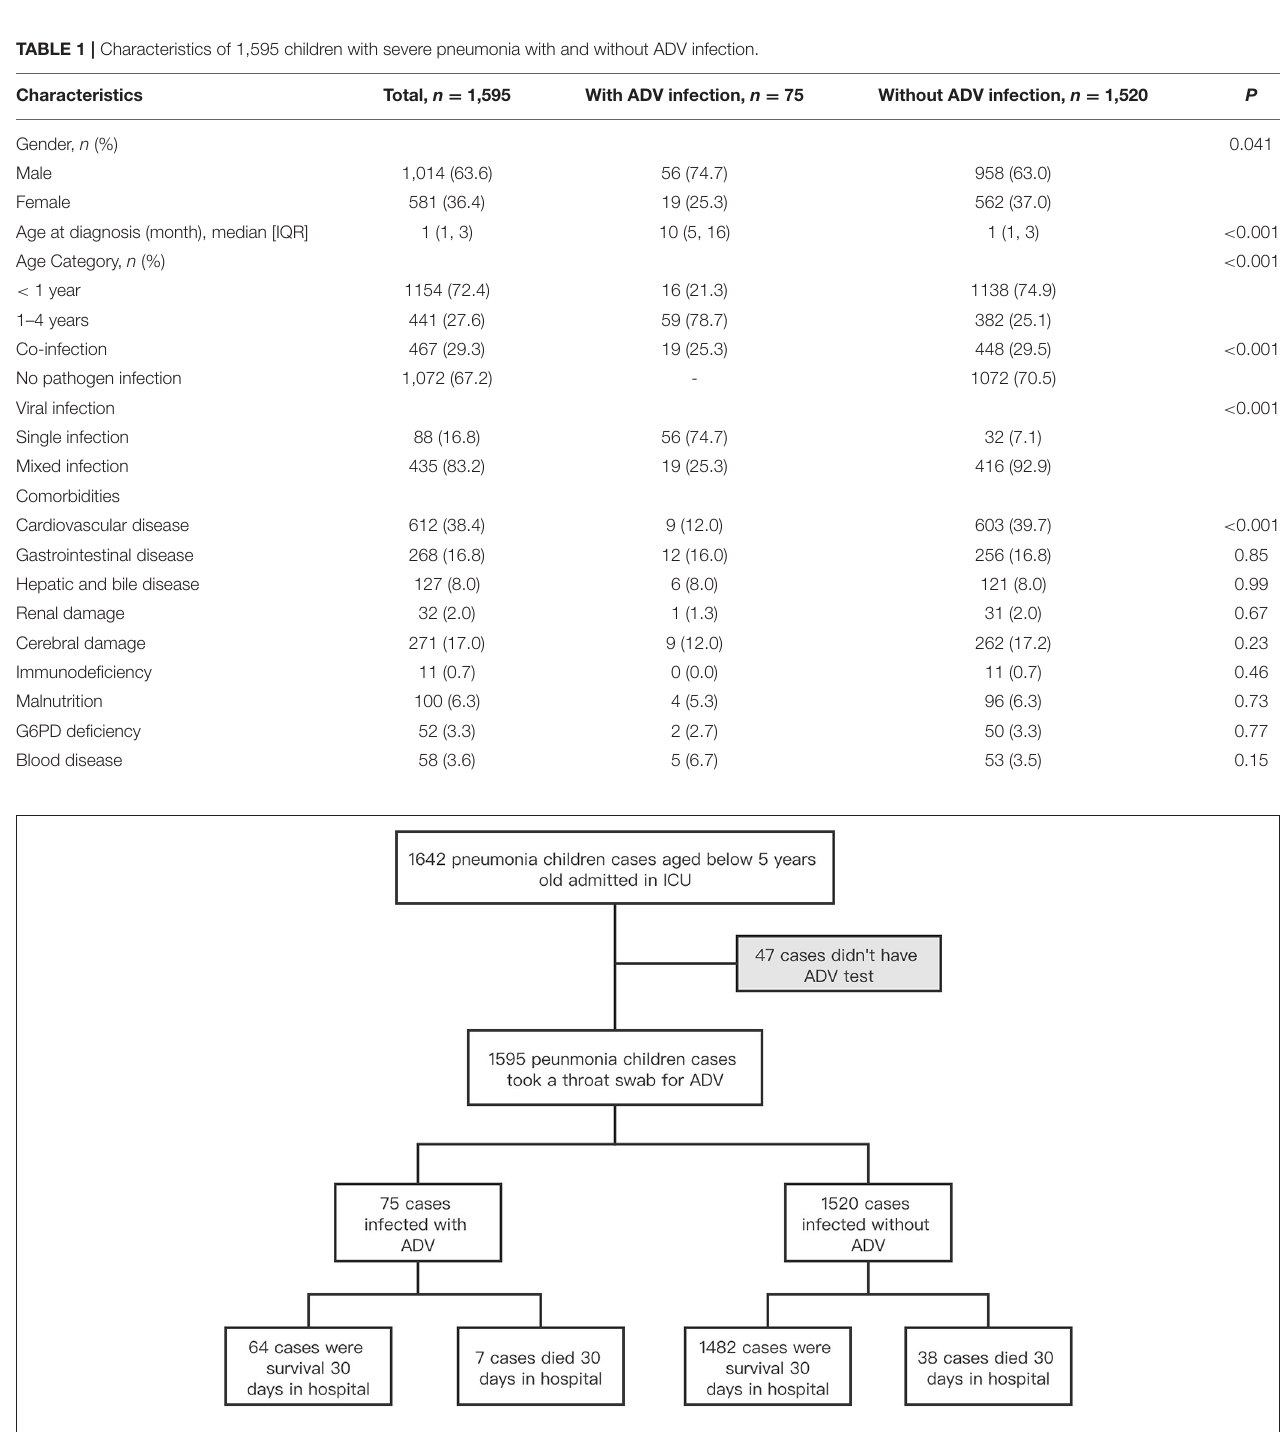
FIGURE 1 | The study flowchart. ADV, adenovirus.